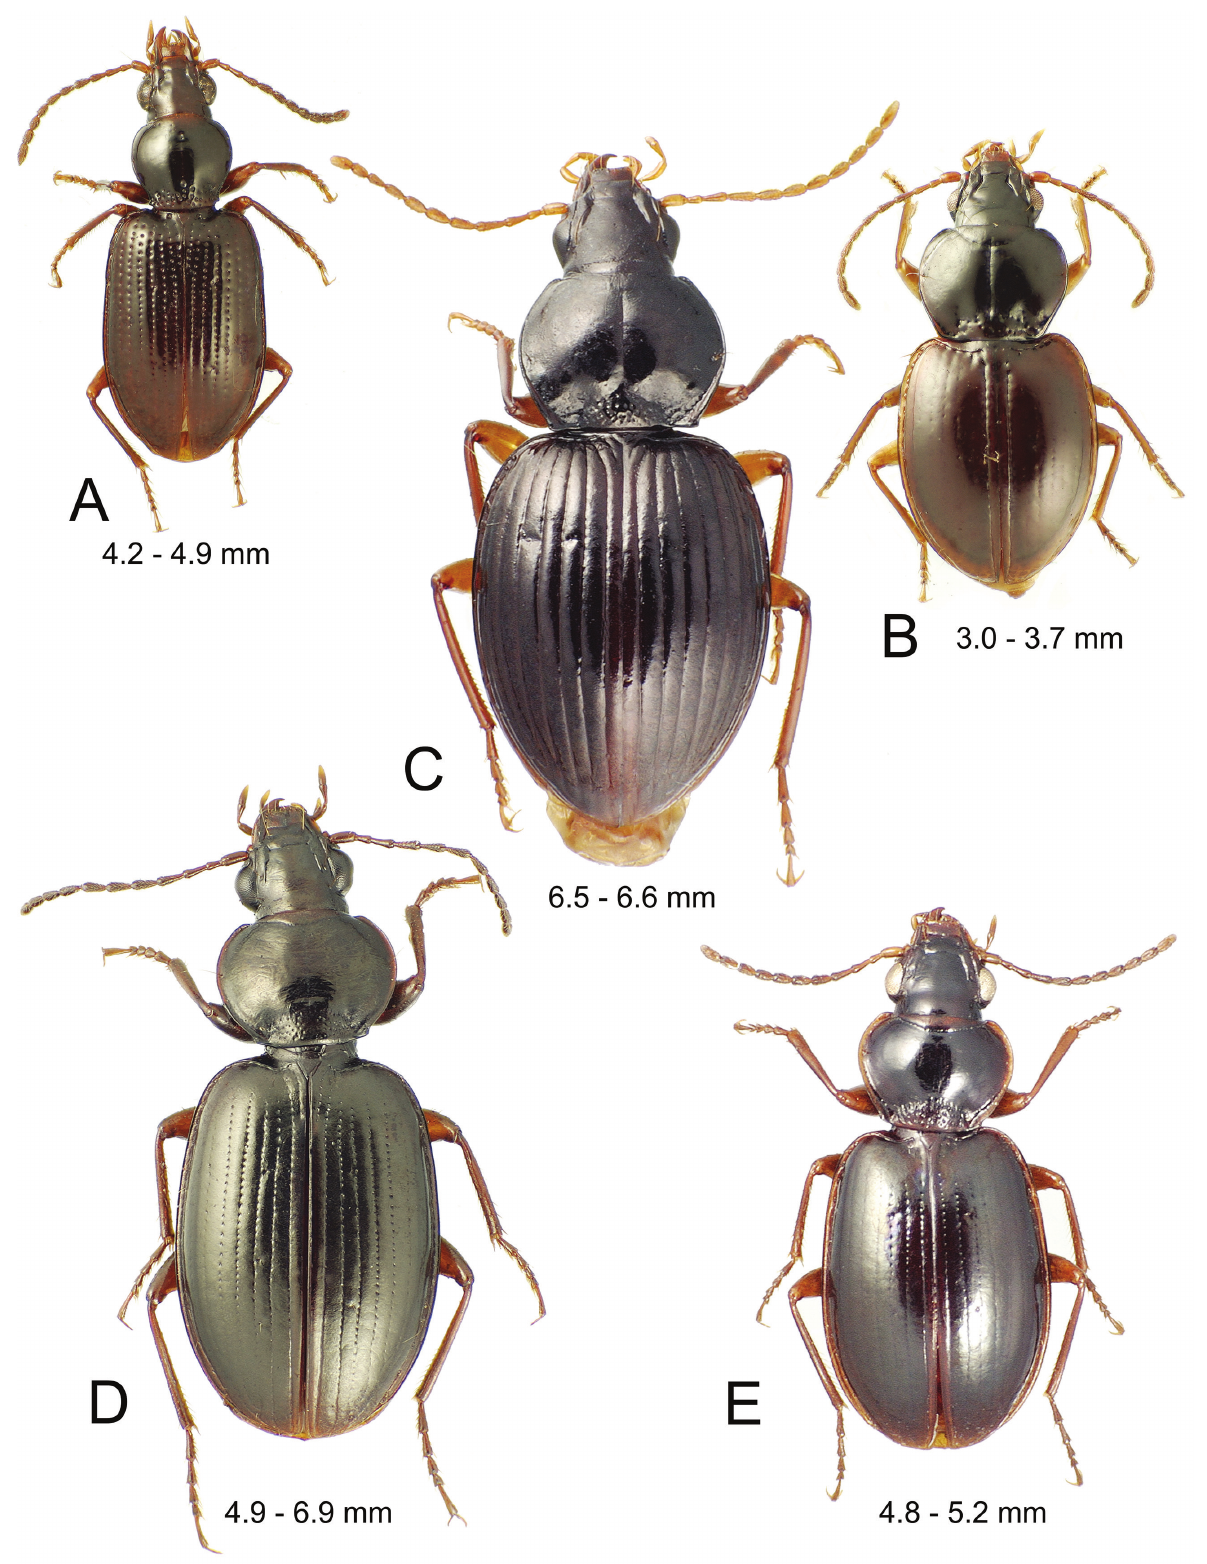
Figure 8. Mecyclothorax spp., dorsal view, with subgeneric assignments: A , M . ( Eucyclothorax , subgen. n.) blackburni (type spe - cies); B , M . ( Qecyclothorax , subgen. n.) storeyi (type species); C , M . ( Meonochilus , status n.) amplipennis (type species); D , M . ( Mecyclothorax ) montivagus (type species); E , M . ( Mecyclothorax ) lissus